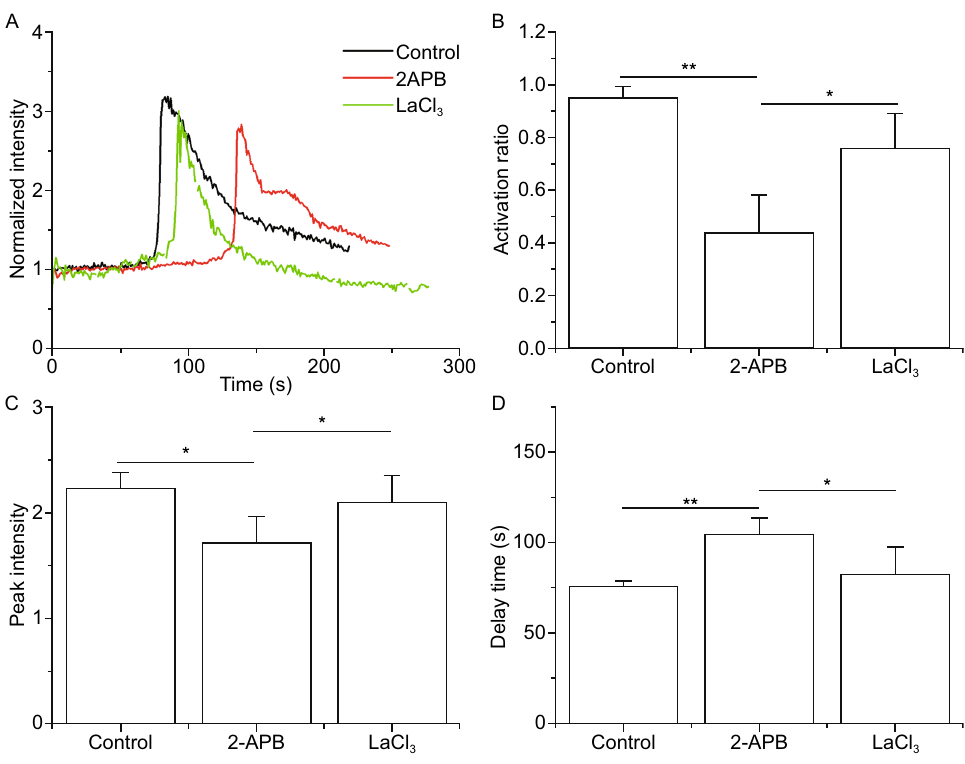
Figure 5. Effects of blocking IP3 and membrane calcium channel on the calcium signaling of neutrophils on P-selectin in fl ow. The time-course (A), activation ratio (B), peak intensity (C) and delay time (D) of P-selectin-induced calcium signaling of neutrophils, treated with the membrane calcium channel blocker LaCl 3 and the IP3 inhibitor 2-APB or nothing, at a wall shear stress of 0.2 Pa. The data represent the mean ± SEM from at least 20 cells in 3 independent experiments. The signi fi cant level of difference from the control group (the cells treated with nothing) is shown by P -value, * P < 0.05, ** P <